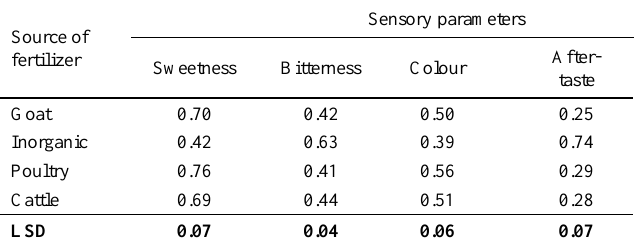
Table 4. The 9-point hedonic scale rating on effects of source of fertilizer on the sensory parameters of baby spinach Sensory Source of fertilizer